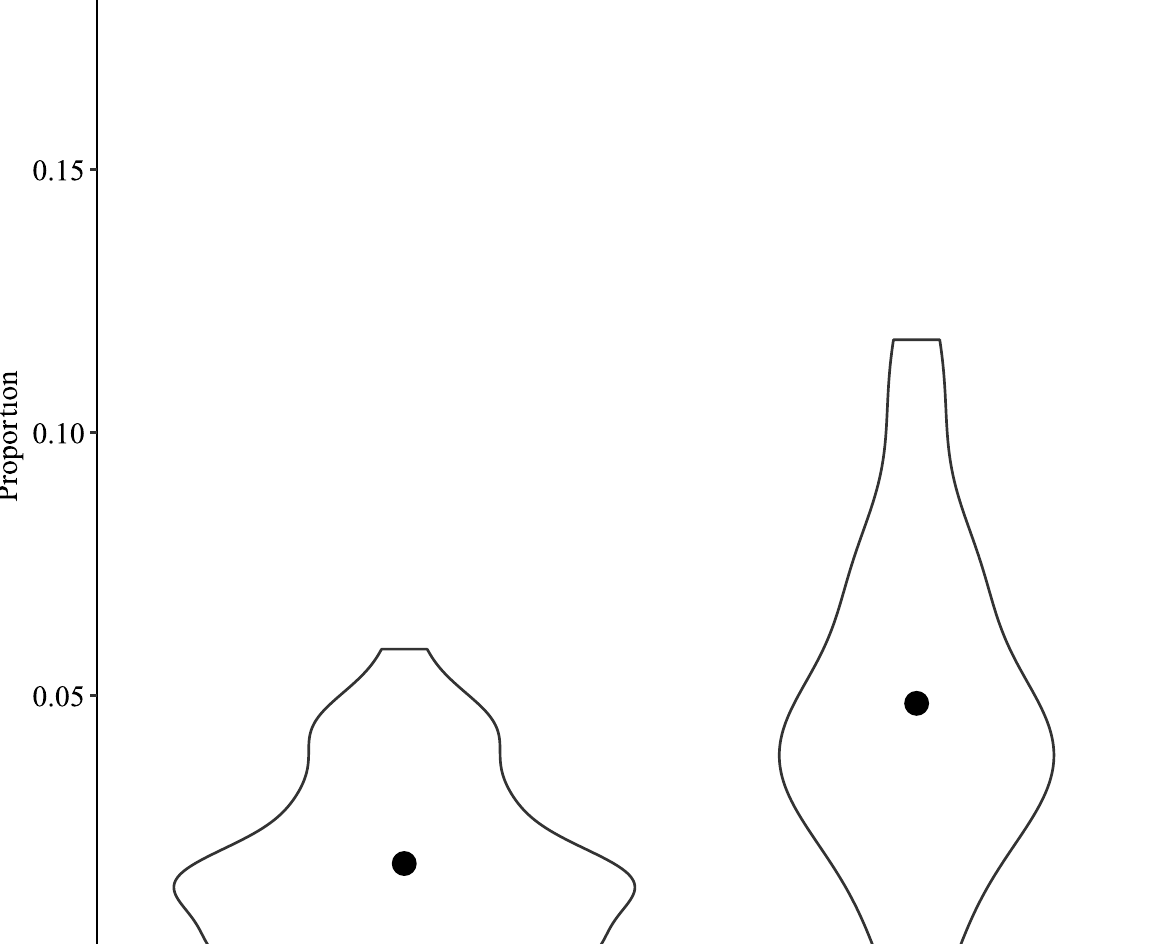
PLOS ONE | https://doi.org/10.1371/journal.pone.0249950 April 14,